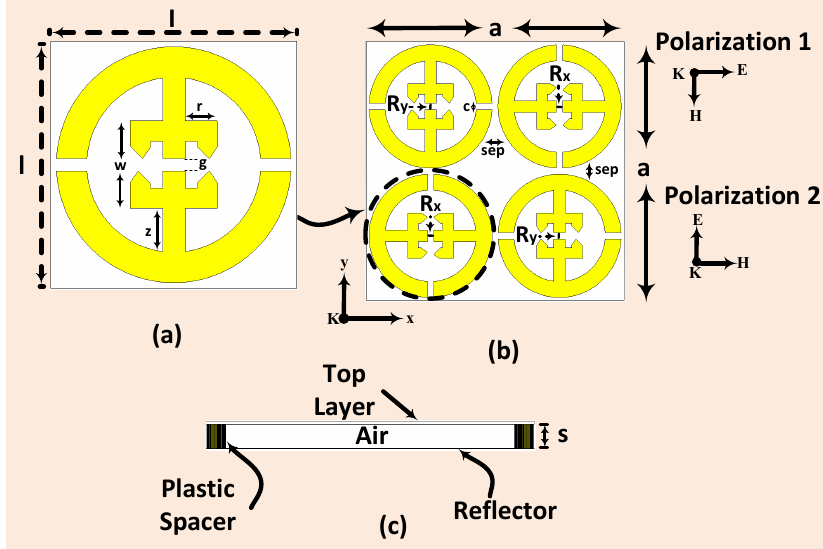
Figure 1. Geometry of the proposed dual polarized planar metasurface for a: ( a ) unit cell, ( b ) 2 × 2 super unit cell ( c ) top layer view of the dual polarized